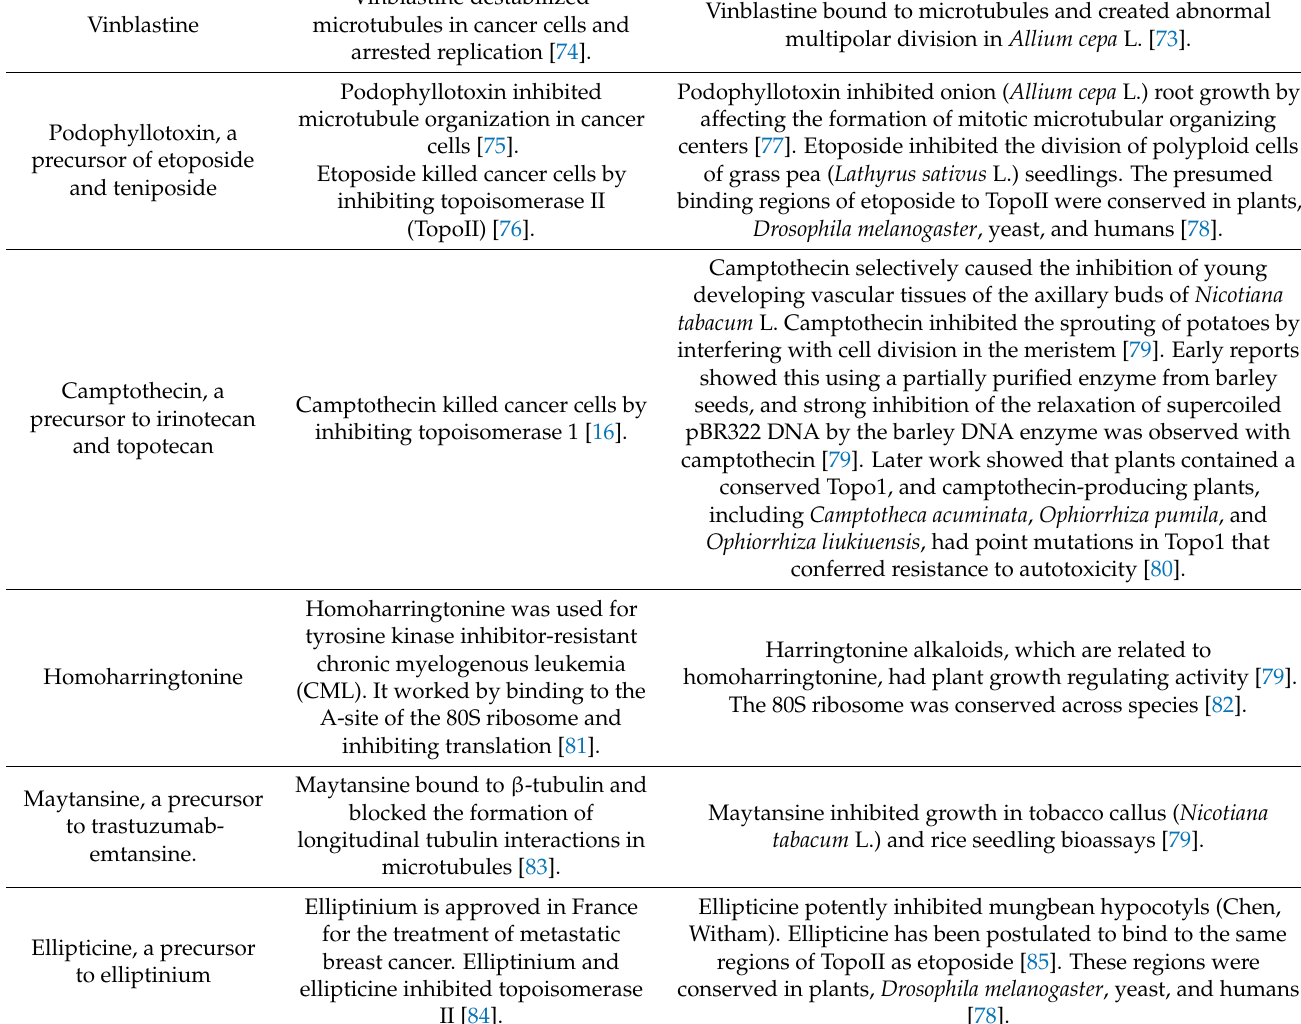
Figure S12: 13 C NMR of Onoseriolide (4); Figure S13: 1 H NMR of Eucannabinolide (5); Figure S14: 13 C NMR of